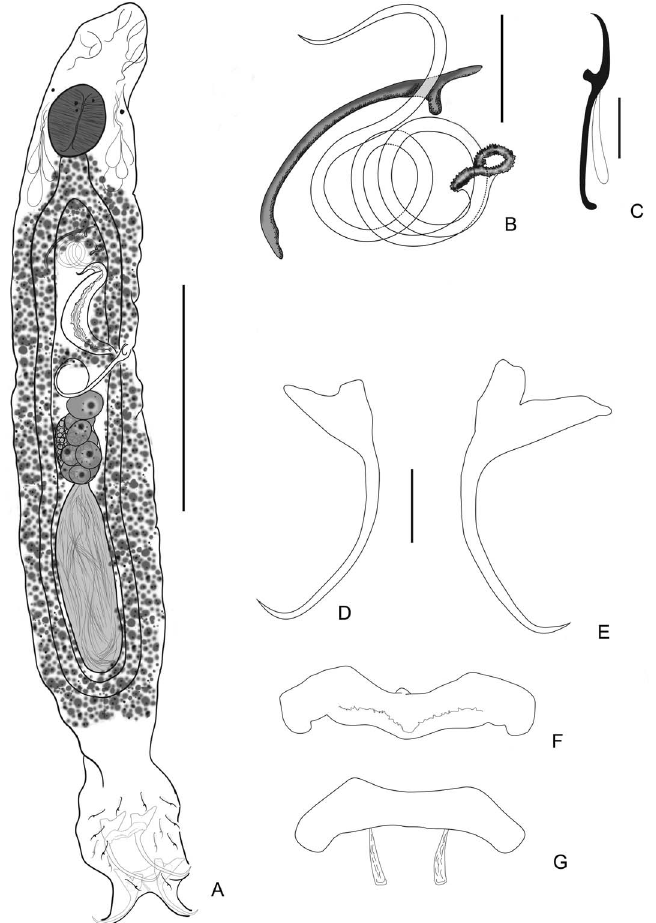
Figure 1. Cosmetocleithrum berecae n. sp. from Auchenipterus nuchalis . (A) Holotype, in ventral view (composite); (B) Copulatory complex, dorsal view; (C) Hook; (D) Ventral anchor; (E) Dorsal anchor; (F) Ventral bar; (G) Dorsal bar. Scale bars: (A) 100 l m; (B) 20 l m; (C) 5 l m; (D – G) 10 l